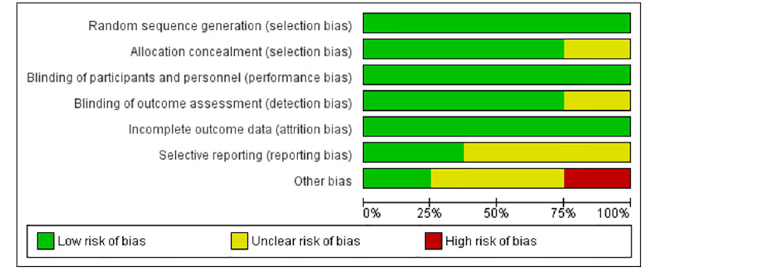
Fig 4. Risk of bias graph for each included study.